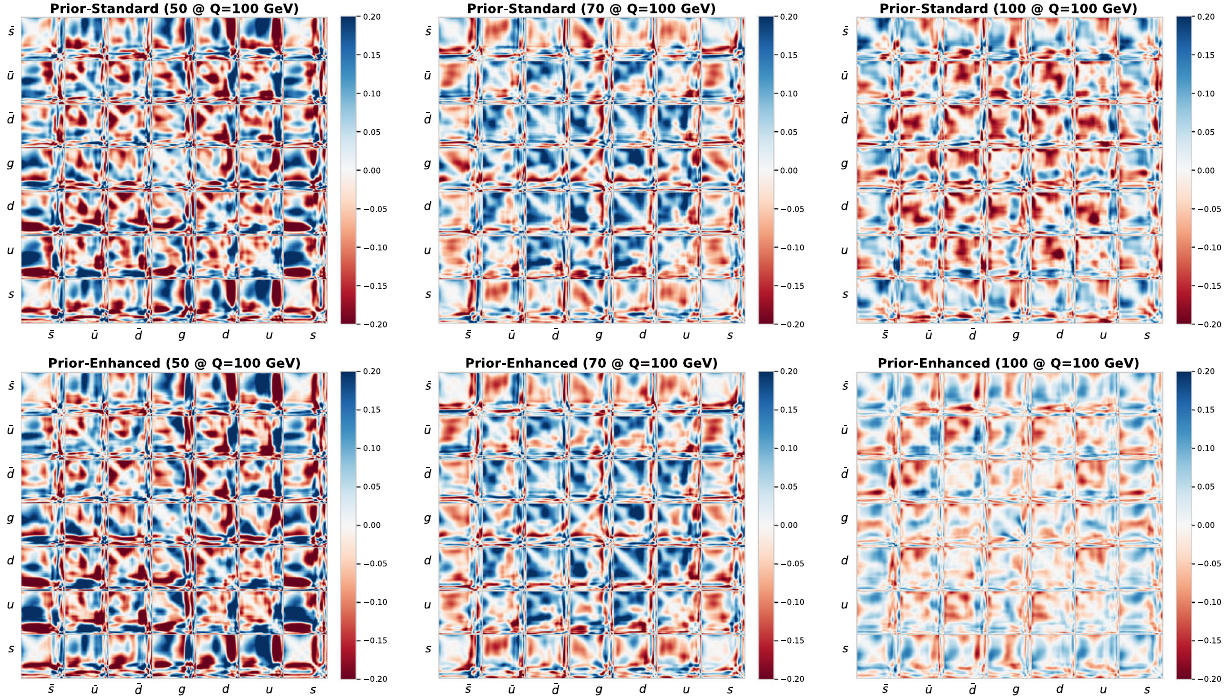
Fig. 13 Difference between the correlation matrices of the prior and the compressed set resulting from the standard (first row) or enhanced (second row) compression. The correlation matrices are shown for dif- ferent sizes of the compressed set: N c = 50 (first column), N c = 70